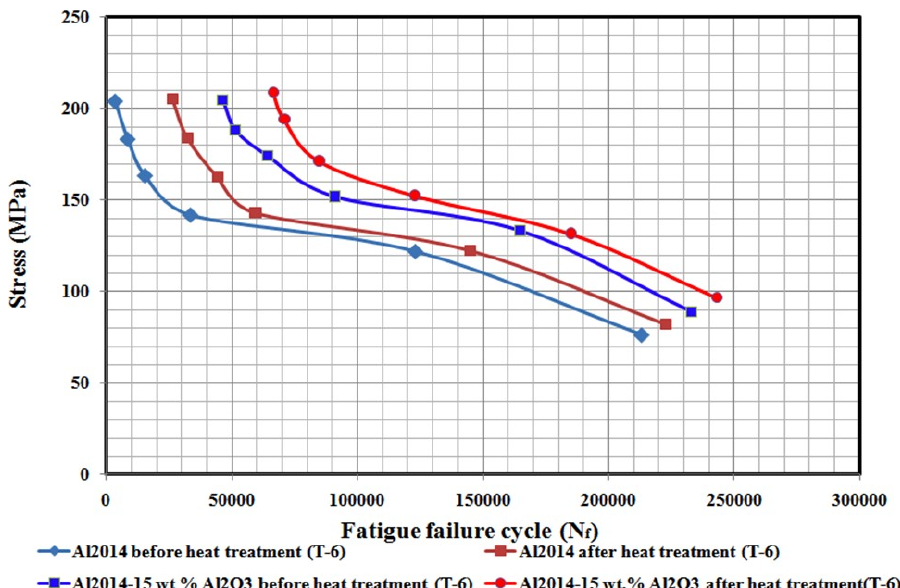
Figure 7. S–Ncurve for the comparison of fatigue behavior of Al2014 and Al2014-15 wt.% Al 2 O 3 composites before and after heat treatment T6.